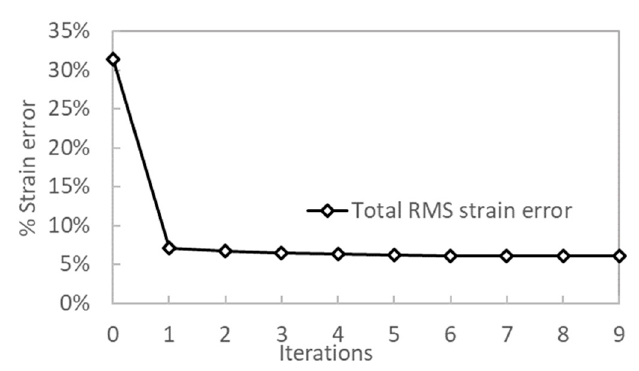
Figure 15. FEMU total weighted RMS strain error for the strain data of the generic unidirectional carbon / epoxy OHC test specimen shown in Figures 12 and 13.